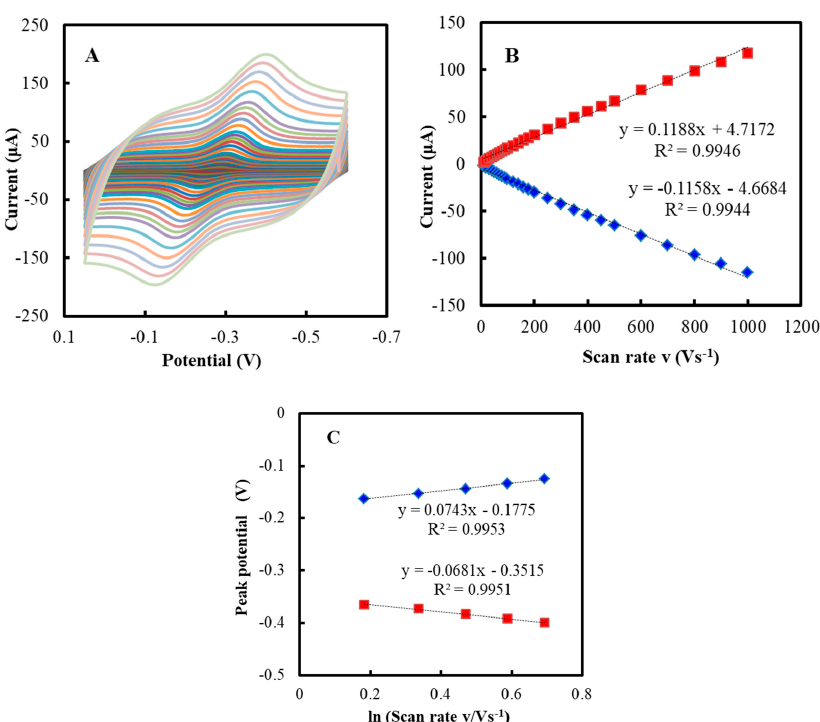
Figure 2. ( A ) CVs of the NF/GluOx/IL/mPEG-fMWCNTs modified GCE in PBS (50 mM, pH 7.0) at different scan rates. ( B ) Plot of peak current ( I p ) versus scan rate ( υ ). ( C ) Plot of peak potential ( E p ) versus ln υ .